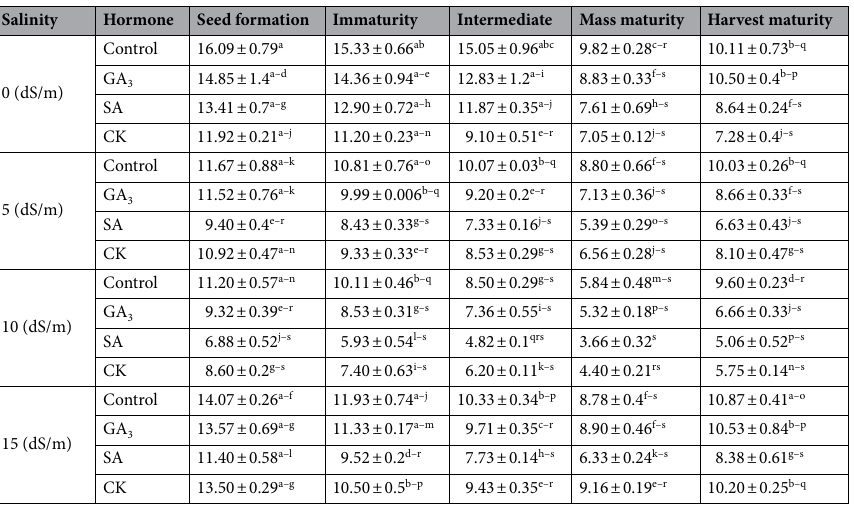
Table 3. Antioxidant activity (IC 50 = mg/mL) of the essential oil from the dill seeds under different salinity and hormonal treatments at different stages of maturity. The values are the means of three replicates ± standard error. GA 3 gibberellic acid, SA salicylic acid, CK cytokinin. Different letters in each column indicate significant difference by Duncan multiple range test at p ≤